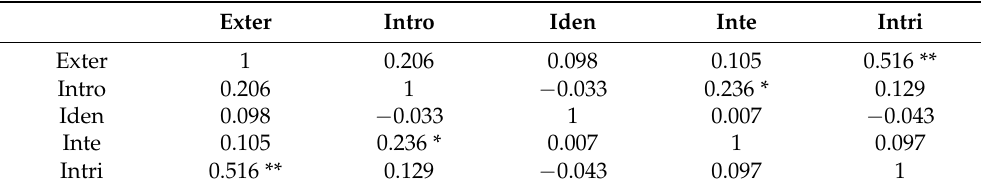
Table A2. Correlations among the five motivational subscales for the group with 5–10 years of experience.